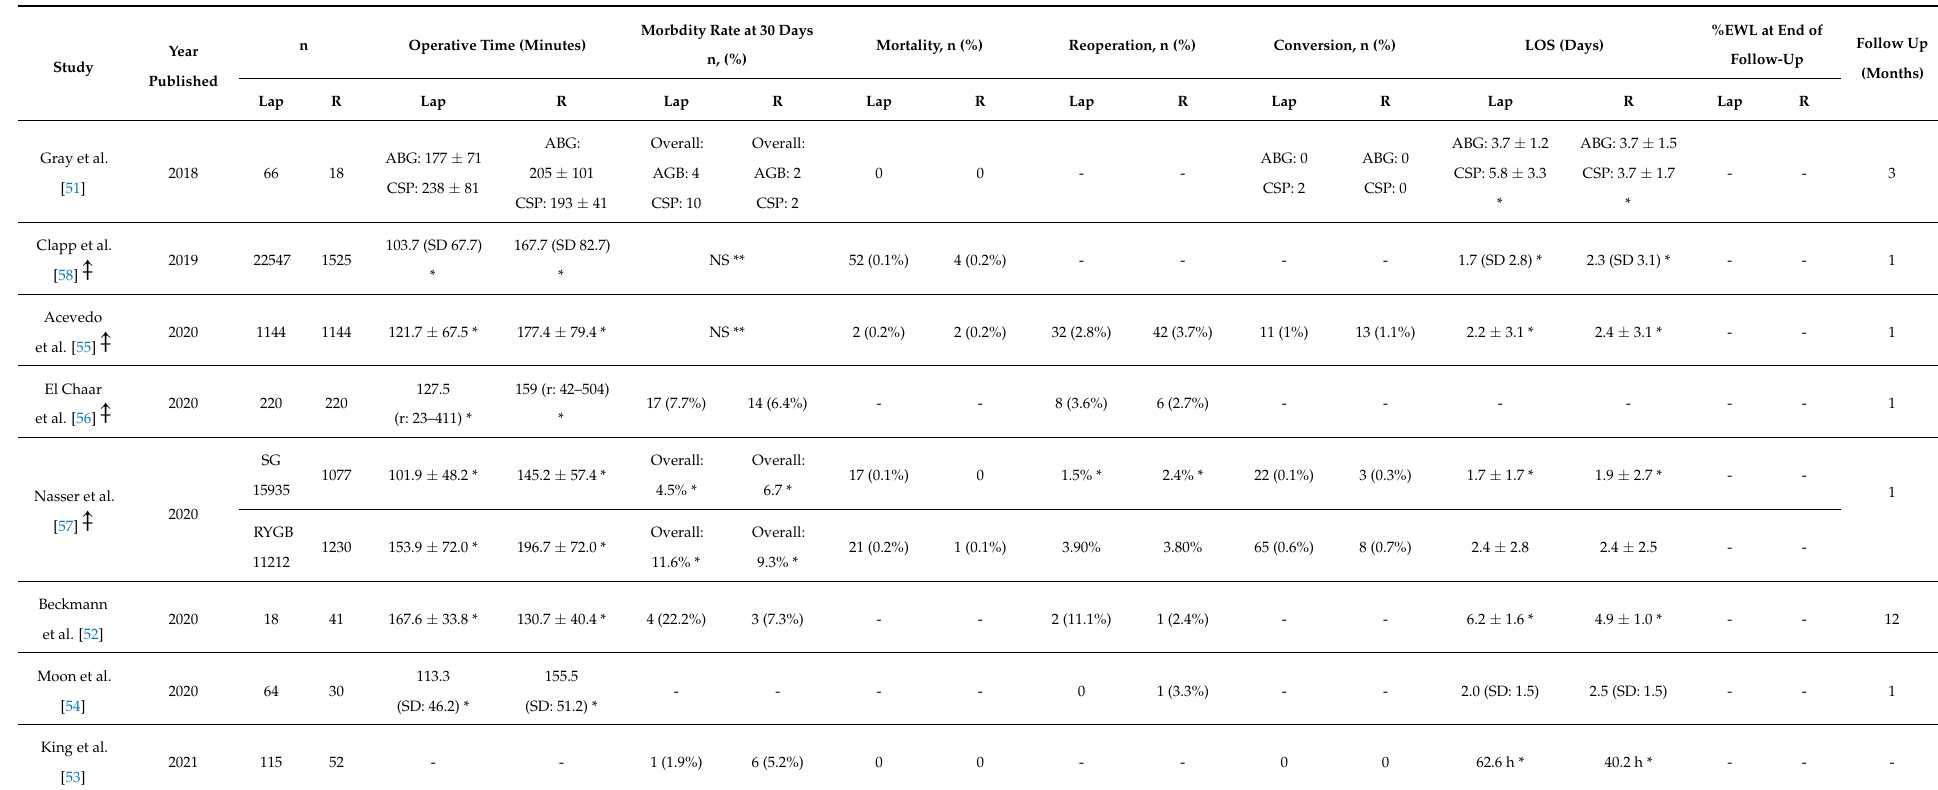
Table 3. Laparoscopic vs. robot-assisted revisional bariatric